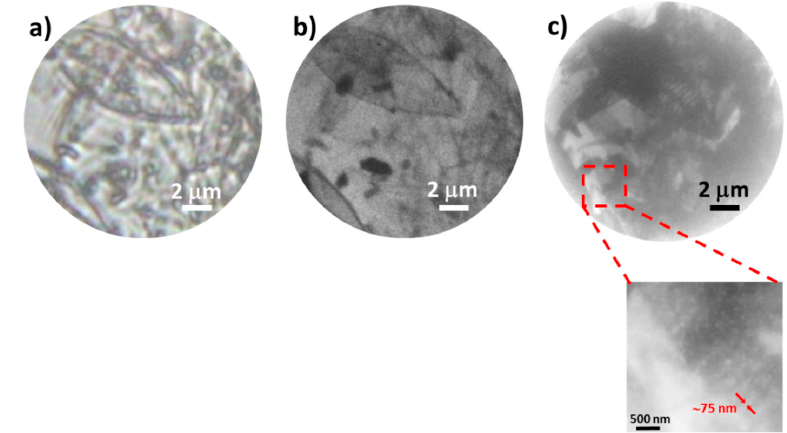
Figure 19. Direct comparison of diatoms, imaged with the visible ( a , c ) and the SXR ( a , b ) microscope. In the zoomed picture of ( c ) are shown small features of ∼ 75nm. Acquisition parameters: 200 SXR pulses, 20 s exposure [91].